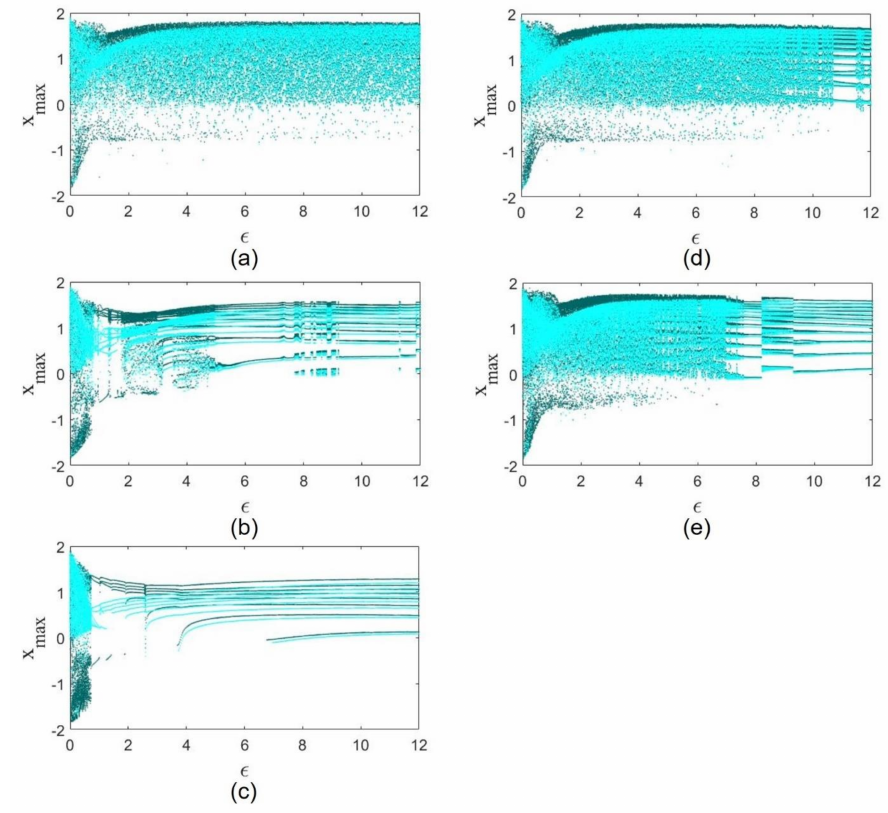
Figure 6. Bifurcation diagrams of the neurons of both layers according to the interlayer coupling strength: ( (cid:101) ) for σ = 0.1; ( a ) q 1 = 1, q 2 = 0.9; ( b ) q 1 = 1, q 2 = 0.8; ( c ) q 1 = 1, q 2 = 0.7; ( d ) q 1 = 0.9, q 2 = 0.8; ( e ) q 1 = 0.8, q 2 =